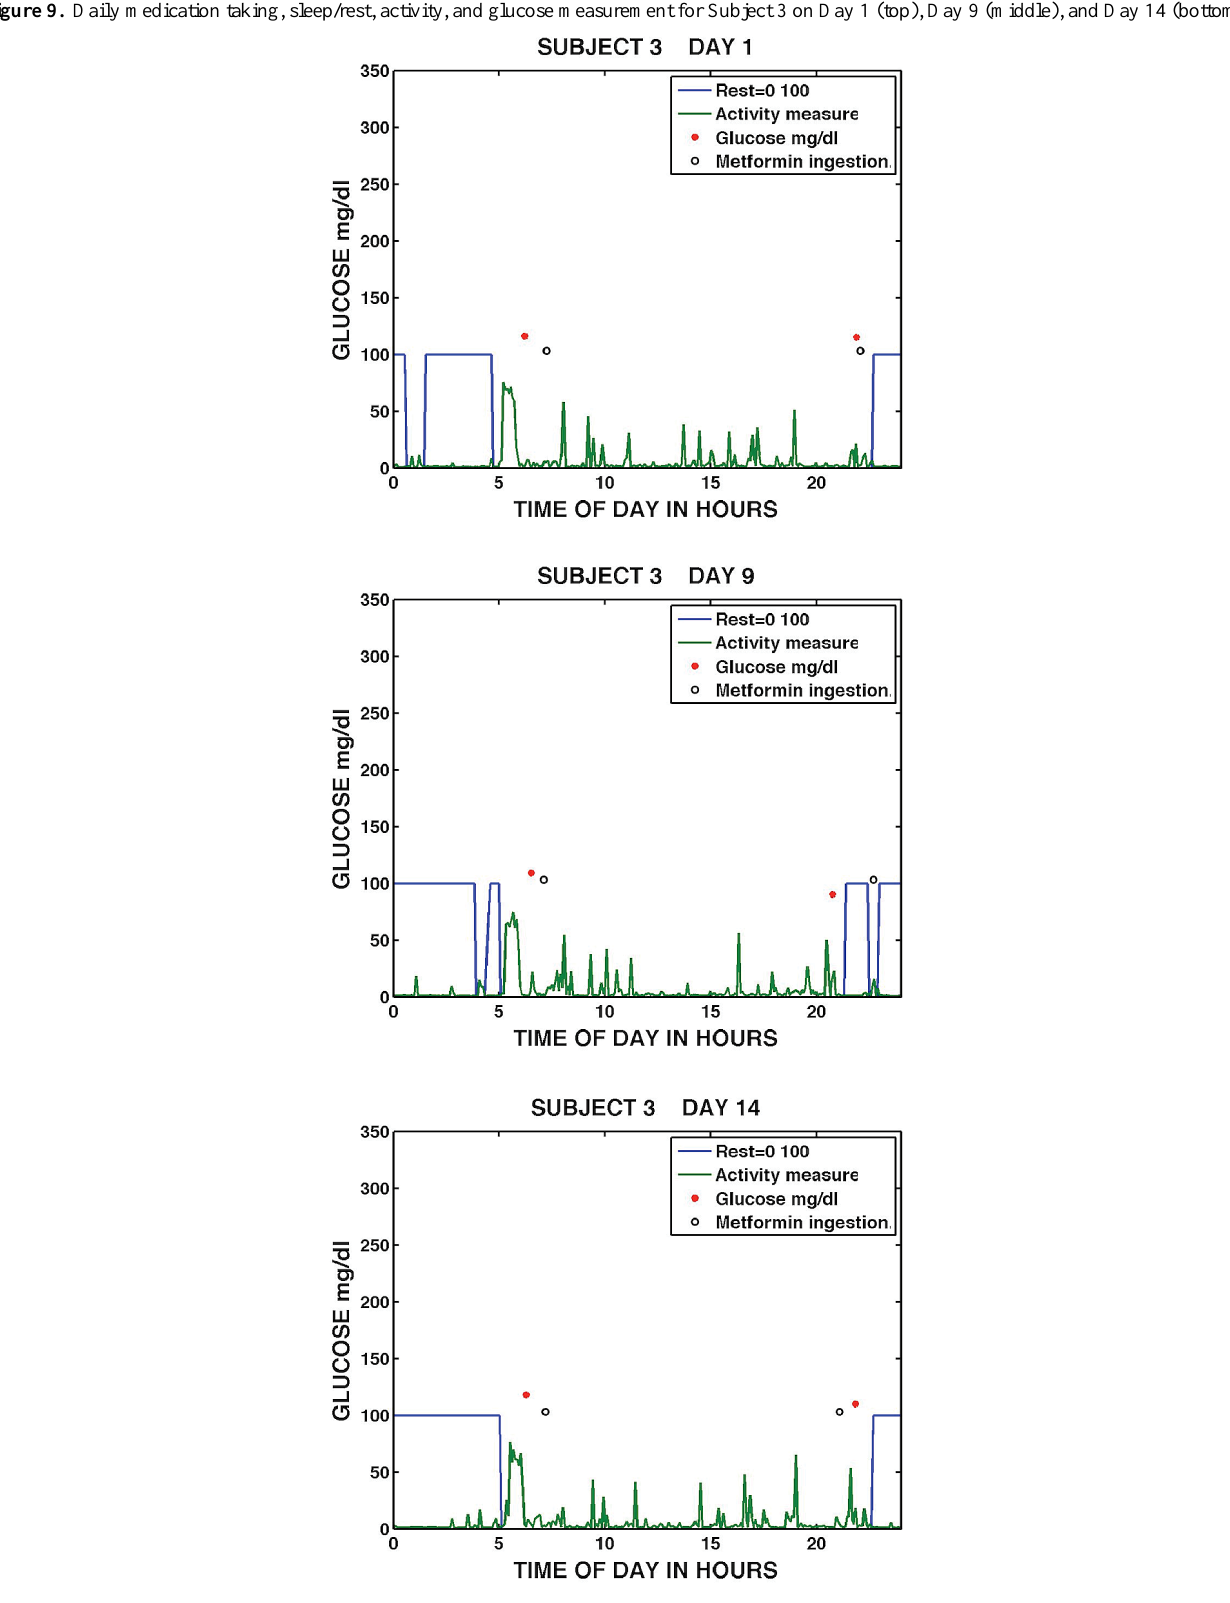
Figure 9. Daily medication taking, sleep/rest, activity, and glucose measurement for Subject 3 on Day 1 (top), Day 9 (middle), and Day 14